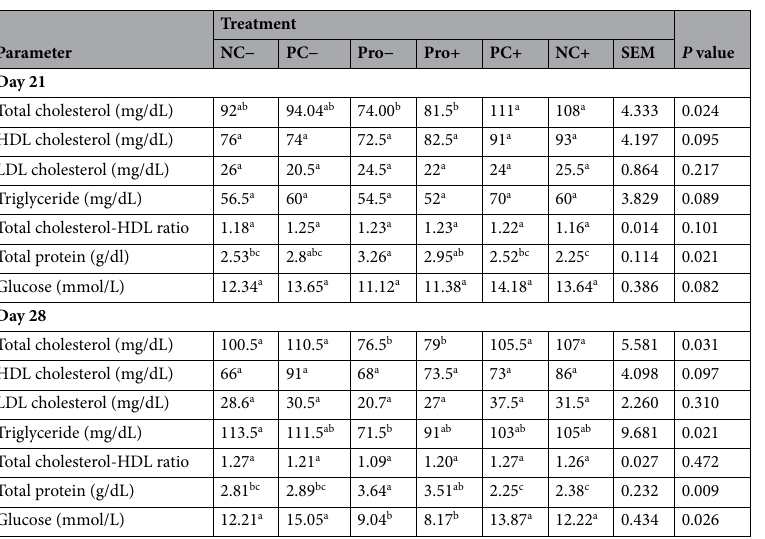
Table 6. Effects of probiotics supplementation on biochemical parameters of Pasteurella multocida challenged broiler chickens. Values are means of two replicates and standard errors of means. Within each variable, values with the same superscript letter are not significantly different according to Duncan’s multiple range test (P > 0.05). NC−: unchallenged negative control; PC−: unchallenged positive control; Pro−: unchallenged probiotics control; Pro+: challenged probiotic control; PC+: challenged positive control; NC+: challenged negative control. HDL high density lipid, LDL low density lipid, RISK total cholesterol-HDL ratio.